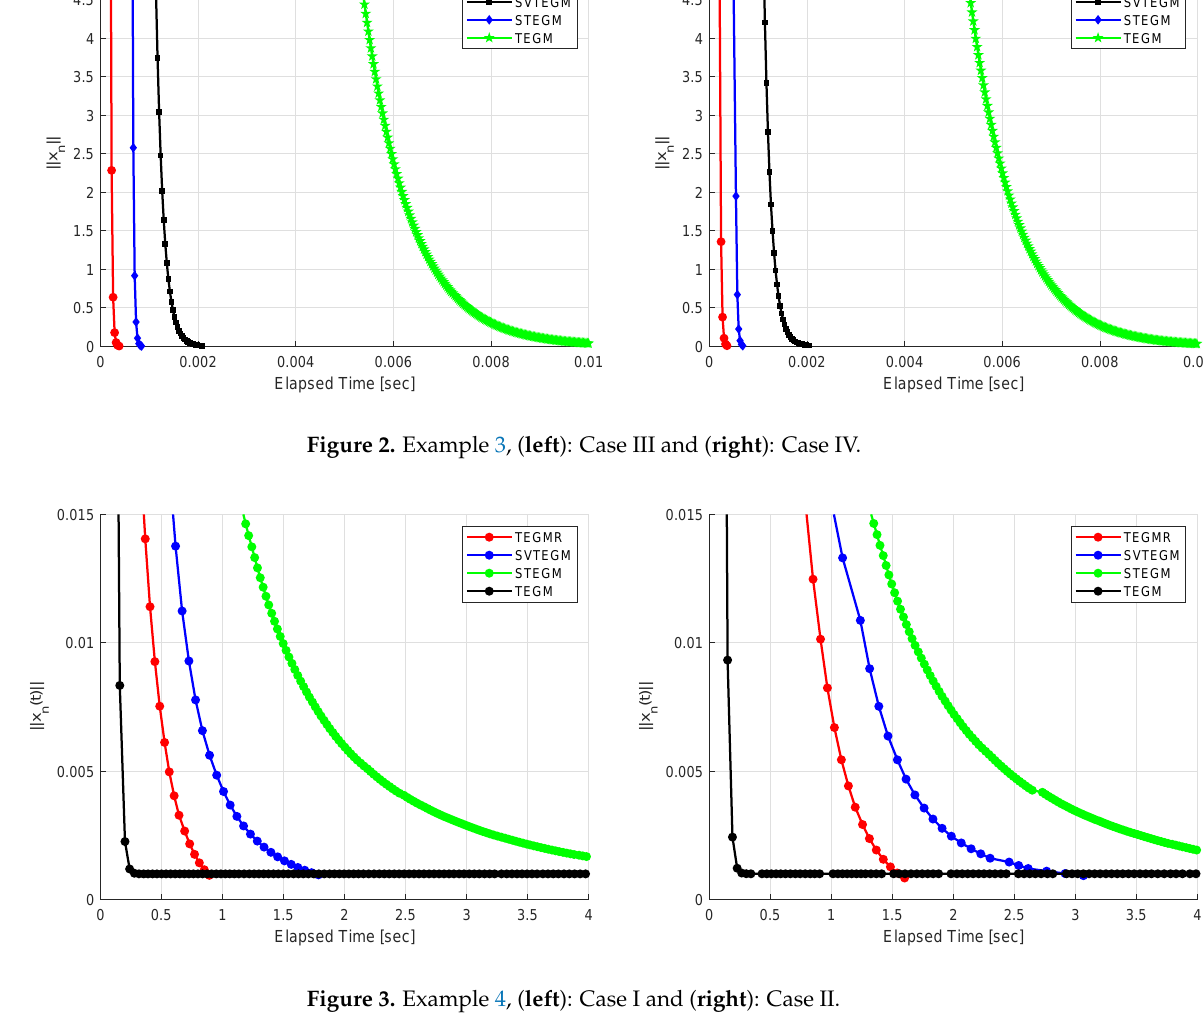
Figure 3. Example 4, ( left ): Case I and ( right ): Case II.